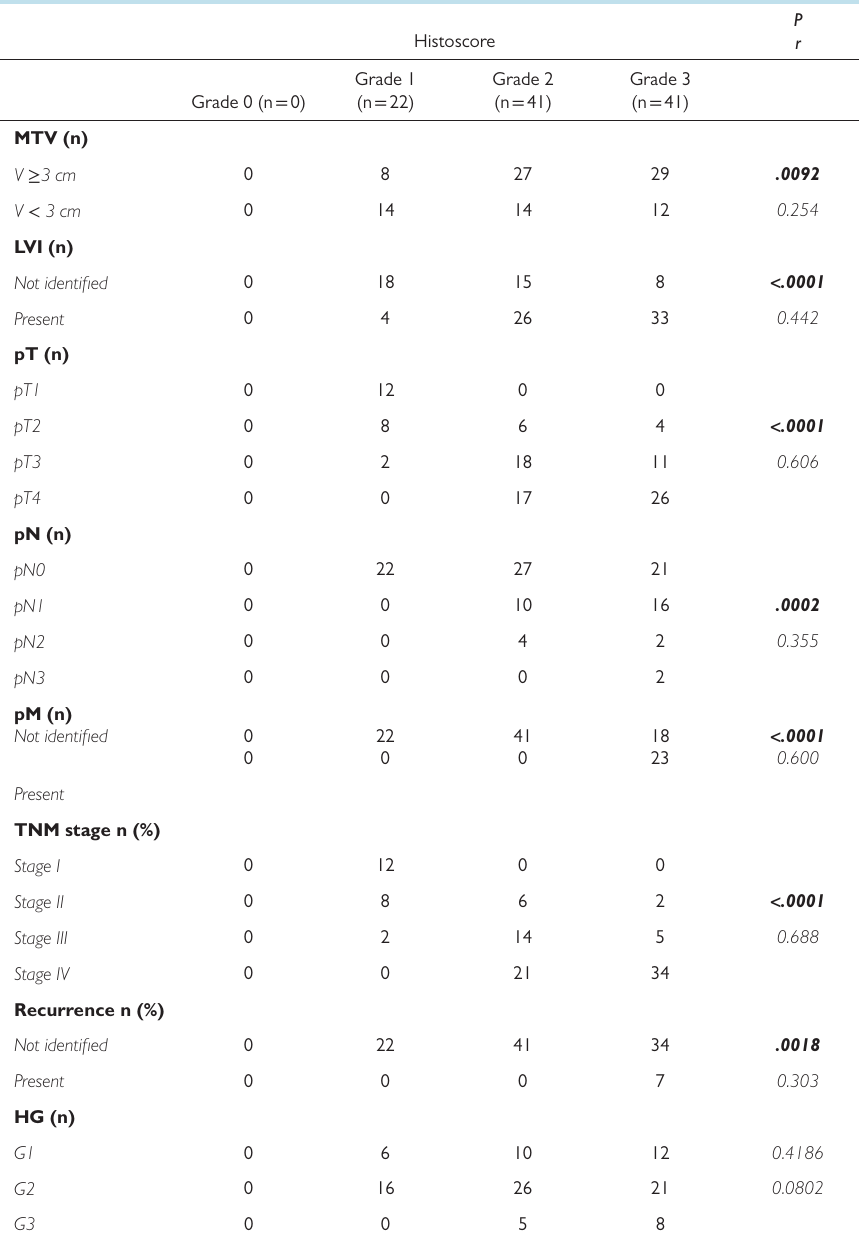
Table 2. Relationship Between Prognostic Factors and HSPA-2 Expression (Spearman’s Correlation